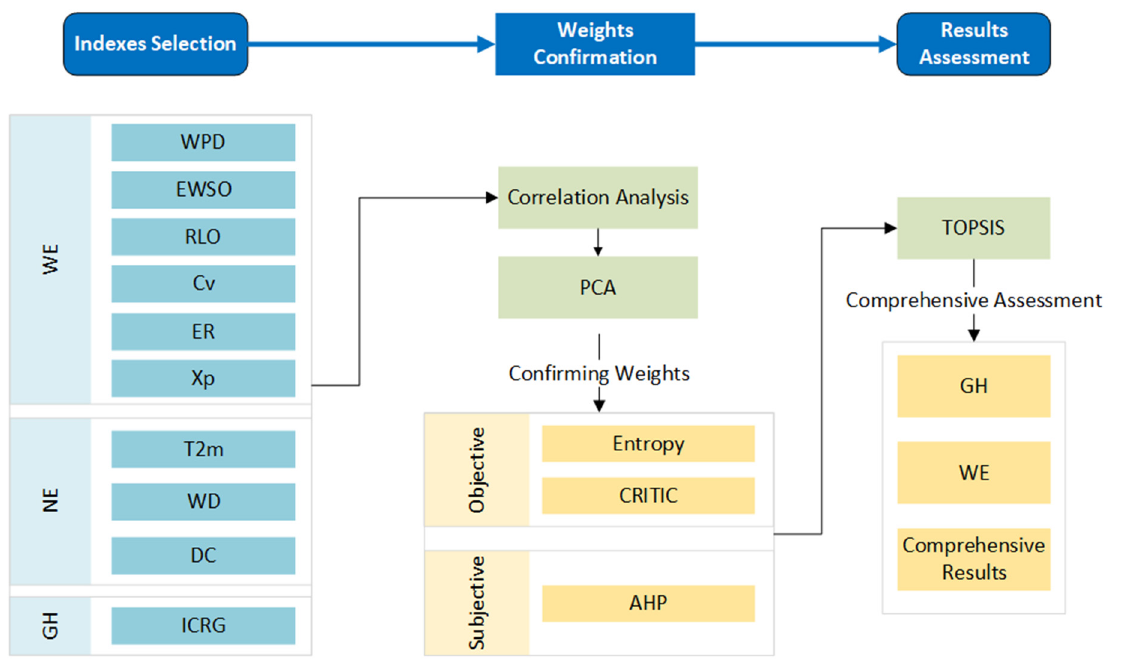
Figure 1. Technical routes (“WE” represents wind energy; “NE” represents natural environment; “GH” represents geography humanities). “GH” represents geography